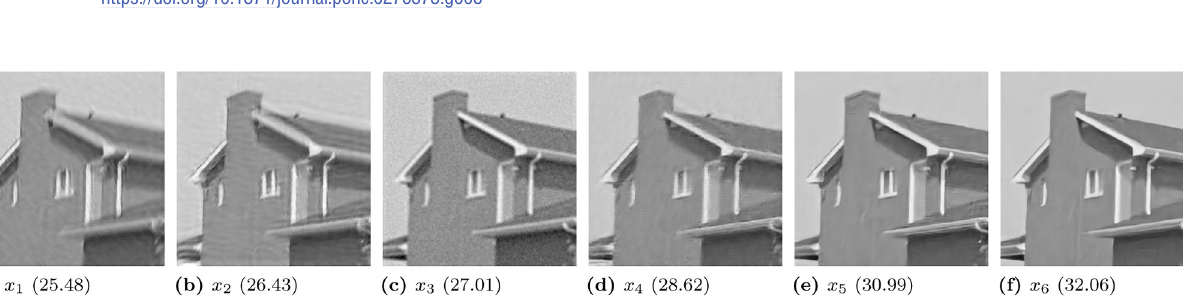
Fig 8. Parameter variations on motion deblurring with kernel size 19. (a): step size and penalty parameter of DPDNN; (b): step size and momentum parameter of FIDNN.